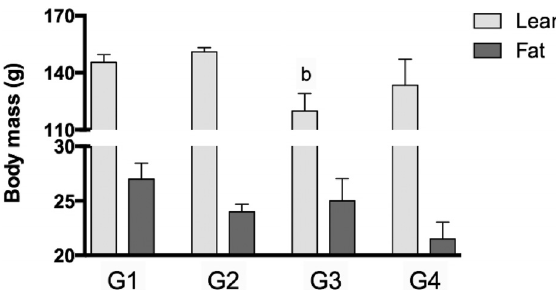
Figure 2 - Lean and fat body mass (g) of non-exercised and exercised rats supplemented or not with coconut oil. Data shown as mean ± standard error. G1 = Sedentary and Non-supplemented (Control Group), G2 = Sedentary and Supplemented Group, G3 = Physical Exercise and Non- supplemented Group, and G4 = Physical Exercise and Supplemented Group. b p<0.05 = Signi fi cance difference of the G2 (ANOVA followed by Holm-Sidak